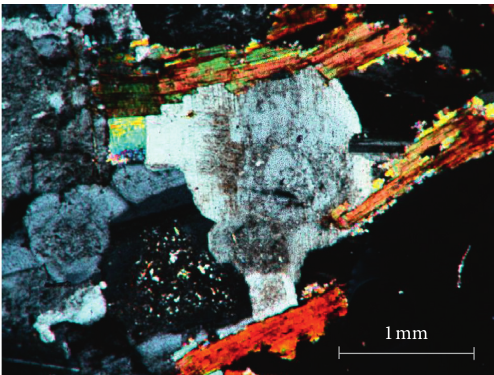
Figure 1: Orthogonal polarized optical photomicrograph of a